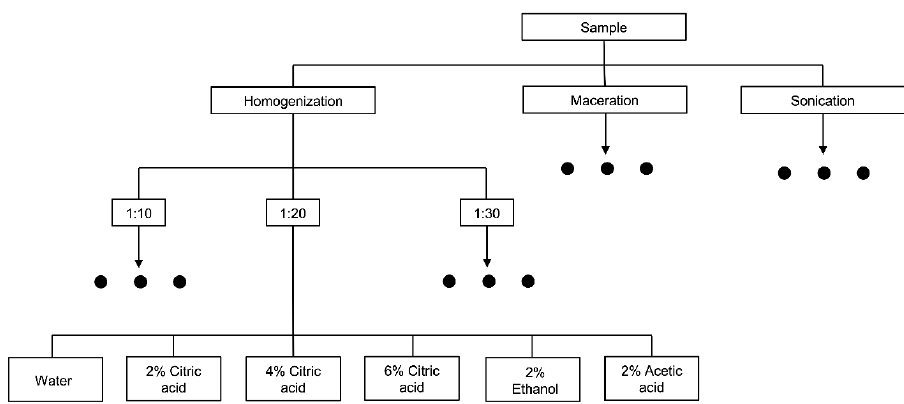
Fig. 1: Experimental design of extraction treatments The black-spot shapes indicate repeated